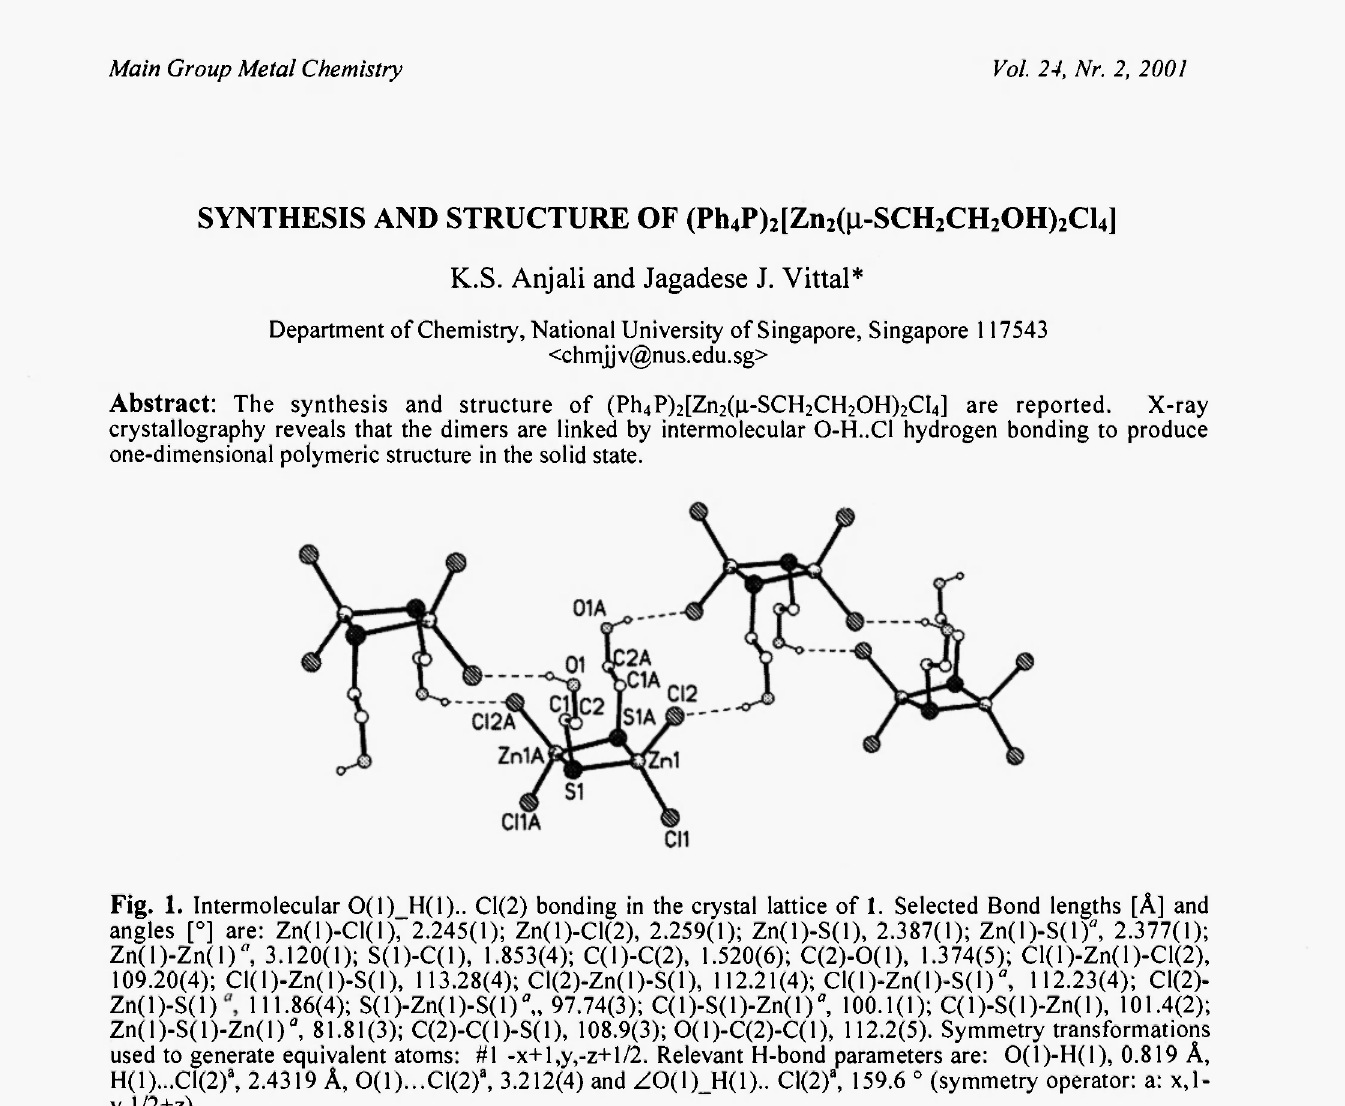
Fig. 1. Intermolecular 0(1)_H(1).. Cl(2) bonding in the crystal lattice of 1. Selected Bond lengths [A] and angles [°] are: Zn(l)-Cl(l), 2.245(1); Zn(l)-Cl(2), 2.259(1); Zn(l)-S(l), 2.387(1); Zn(l)-S(lf,